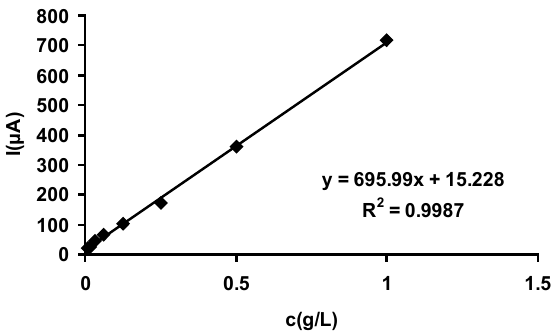
Figure 8: Detail on the calibration graph at sulfite concentrations below 1 g L -1 , obtained with the Pt strip electrode